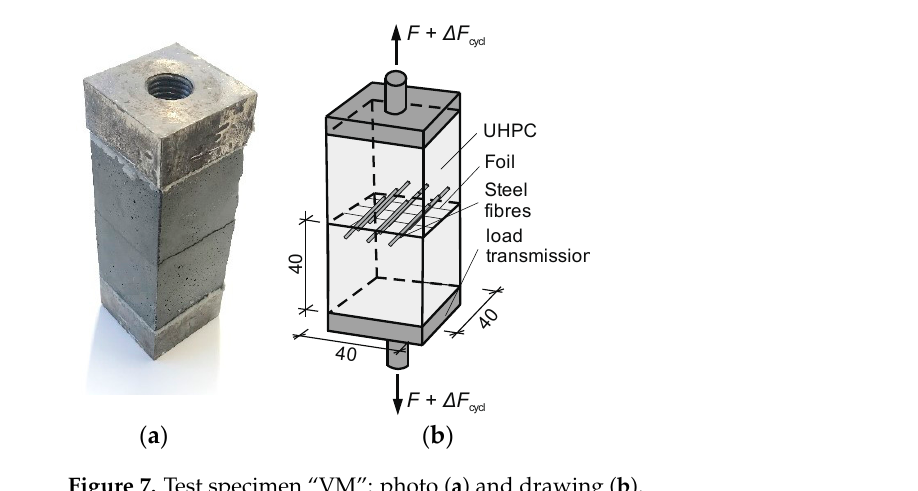
Figure 7. Test specimen “VM”: photo ( a ) and drawing ( b ). The production of the test specimens needed two casting steps. First, nine steel fibres with a diameter of ∅ f = 0.19 mm and a length of l f = 13.0 mm were put with a 1 cm × 1 cm grid in a polystyrene cube, so that half (or 3/4) of the fibre was in the cube and the other half (resp. 1/4) was “on the air”. A template ensured the desired orientation α and embedded length l e of the fibres. Afterwards, the polystyrene cube with the aligned steel fibres was placed in a formwork. Then, the concreting of the first half of the test specimen followed. After one day of hardening, the polystyrene cube was removed. Subsequently, the second concreting was carried out. A foil between the UHPC cubes prevented transmission of tensile forces between the concrete. Bonded steel plates with threaded holes ensured load transmission between the testing machine and the specimen. The experimental programme of the pullout tests contained a variation of the fibre orientation between α ≈ 30 ◦ , 60 ◦ , and 90 ◦ as well as different embedded lengths of l e ≈ 6.50 mm ( l f /2 ) and l e ≈ 3.25 mm ( l f /4 ) . The displacement transducer of the testing machine measured the displacement of the two UHPC cubes and the so-called “crack mouth opening displacement”. A comparative measurement between the transducer and an optical laser in preliminary tests confirmed its accuracy. The loading velocity was 0.01 mm/s (cf. Section 4.2) for the monotonic tests. The load amplitude of the cyclic tests oscillated between 10% and 70% of the maximum pullout resistance of the monotonic tests. The test frequency of the cyclic tests varied between 0.5 and 1 Hz. Table 6 shows the test programme including typical results. Table 6. Experimental programme and test results of the monotonic and cyclic loaded pullout